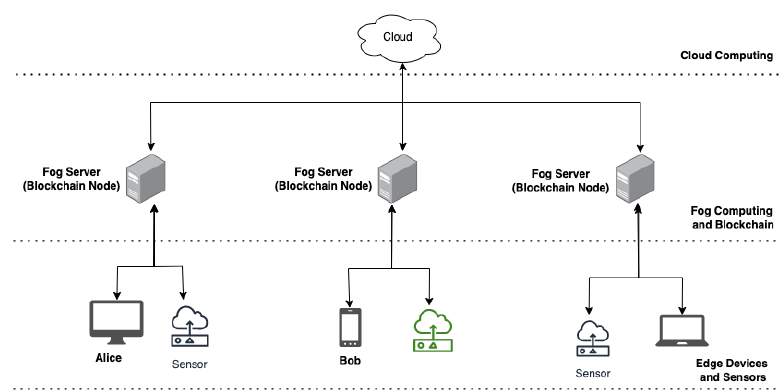
Figure 1. System architecture for fog-enabled blockchain-based authentication